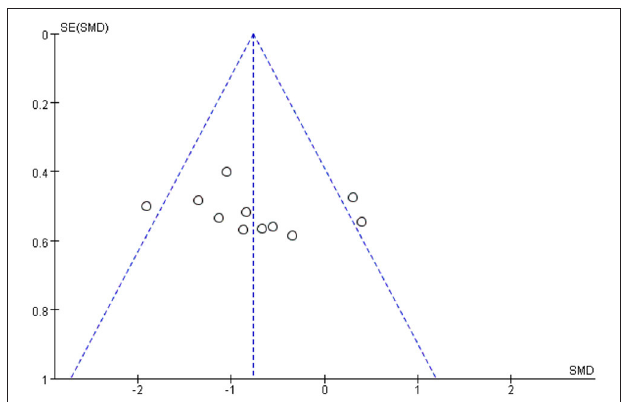
FIGURE 3 | Funnel plot for the publication bias of overall swallowing